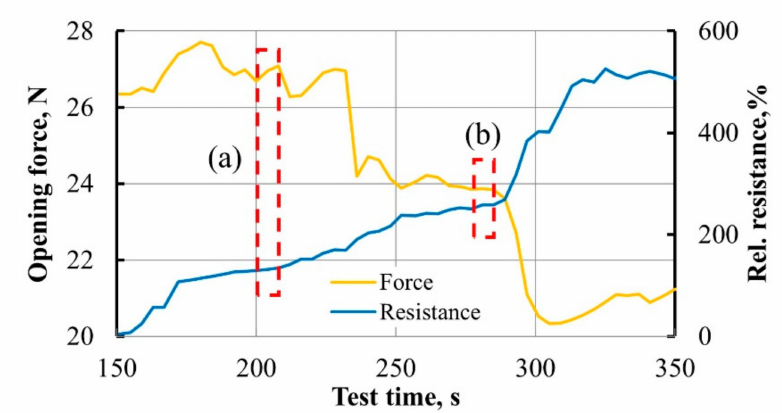
Figure 20. The opening force F and relative resistance R rel in time during crack propagation for neat epoxy-based DCB specimens with MWCNT spray-coated interleave. Red sectors ( a ) and ( b ) are examined in Figure